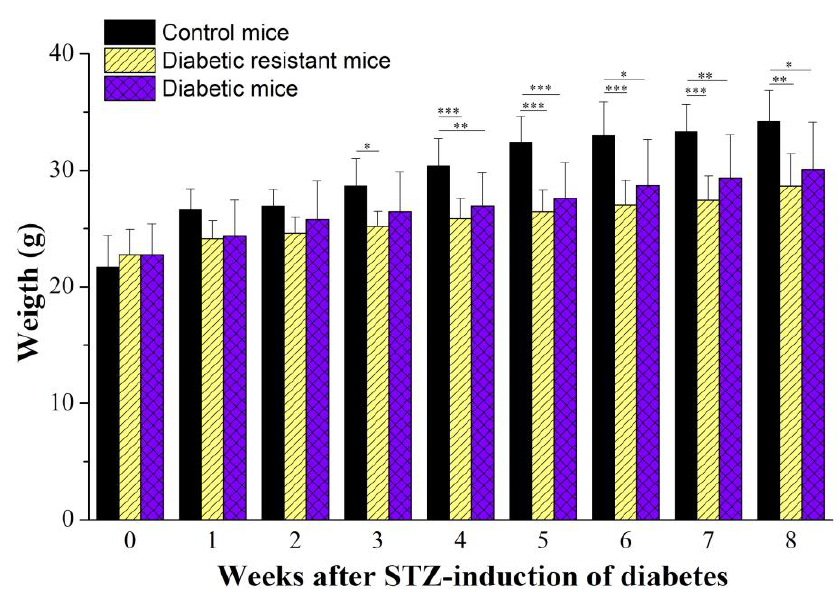
Figure 2. Body weight (in g) monitored for 8 weeks after streptozotocin (STZ)-induction of diabetes. Body weight values were represented as mean ± SD for control, diabetic resistant, and diabetic mice. Statistical significance is indicated * p < 0.05, ** p < 0.01, *** p < 0.001.